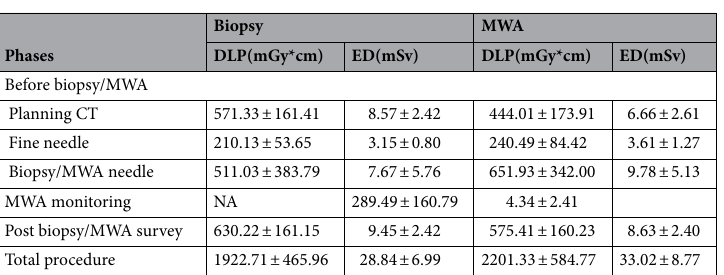
Table 4. Effective radiation dose. DLP, ED, MWA, are the abbreviations of dose length product, effective dose, and microwave ablation,